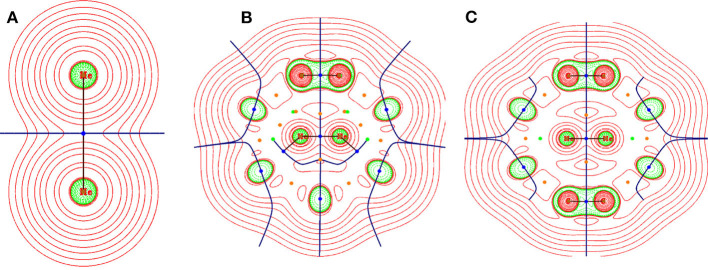
Contour plot representation of Laplacian of electron density at a particular plane of (A) He2, (B) He2@C36, and (C) He2@C40. Red region depicts the area having ∇2 ρ(rc) > 0 and green region depicts the area having ∇2 ρ(rc) < 0.